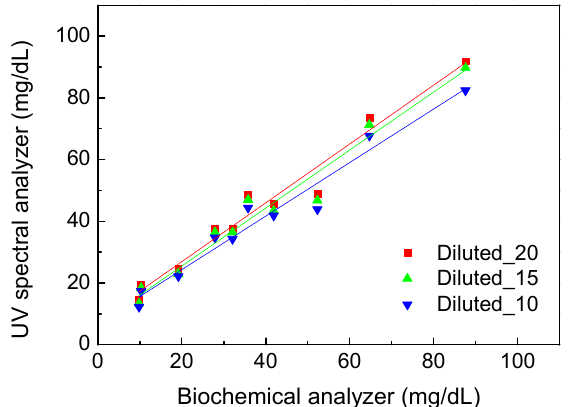
Figure 4. ( a ) The coefficient of determination distribution between the absorbance and the uric acid concentration of urine samples at wavelength 240–320 nm. ( b ) The relationship between the absorbance and the uric acid concentration of urine samples at 300 nm. The coefficient of determination reached its highest level at 0.9633.